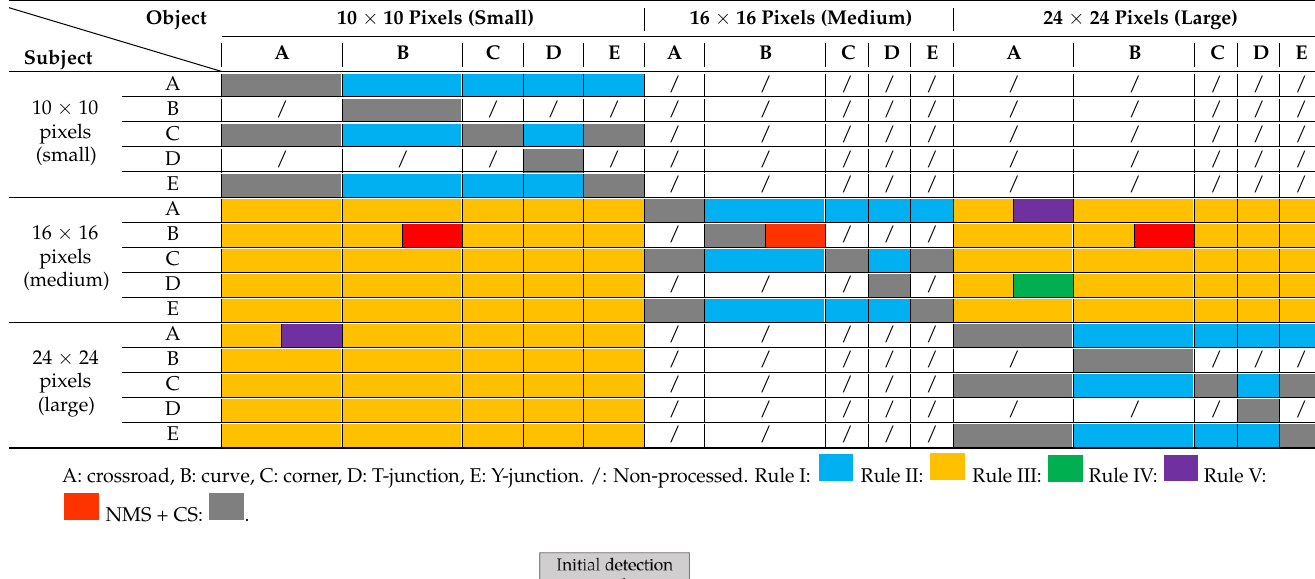
Table 1. Combination rules.